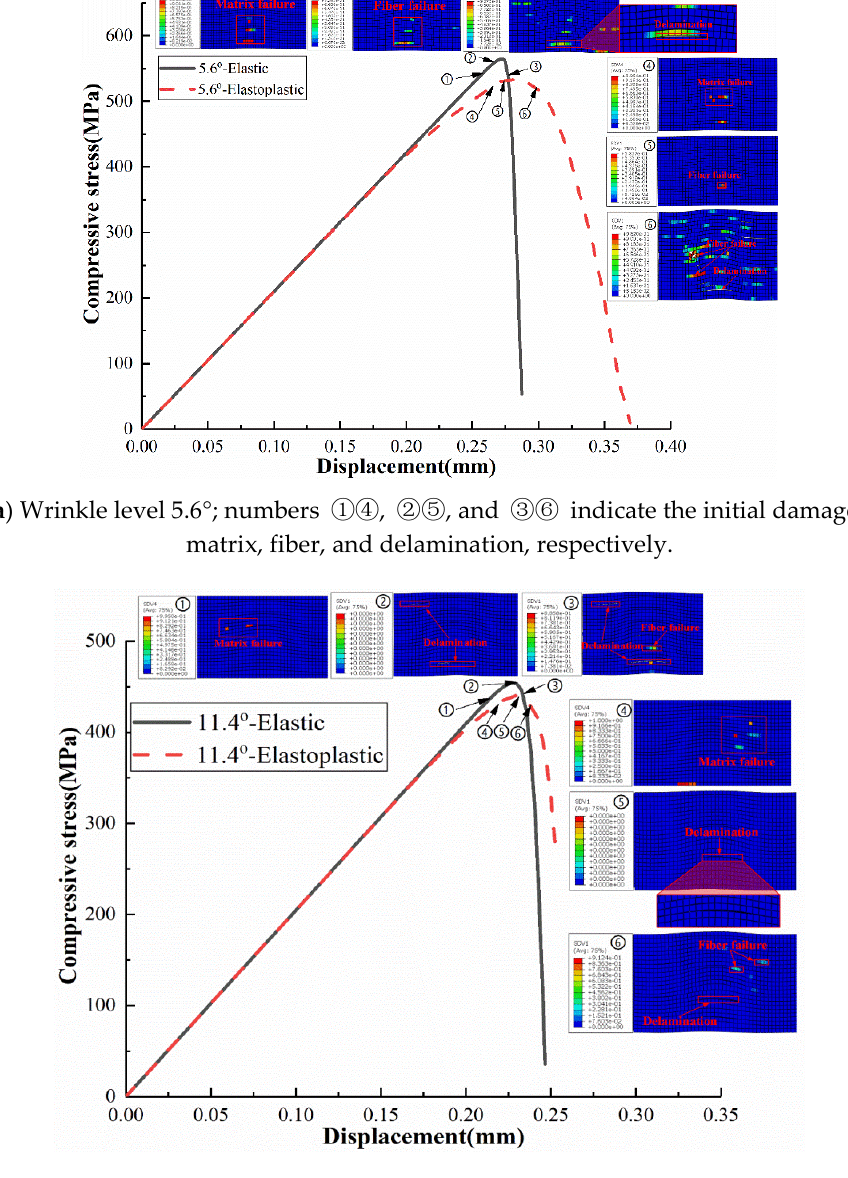
Figure 20. Predicted compressive stress versus displacement for wrinkle levels 5.6° and 11.4°. Numbers ①②③ indicate the damage initiation obtained from the elastic model, whereas ④⑤⑥ indicate that derived from the elastoplastic model.